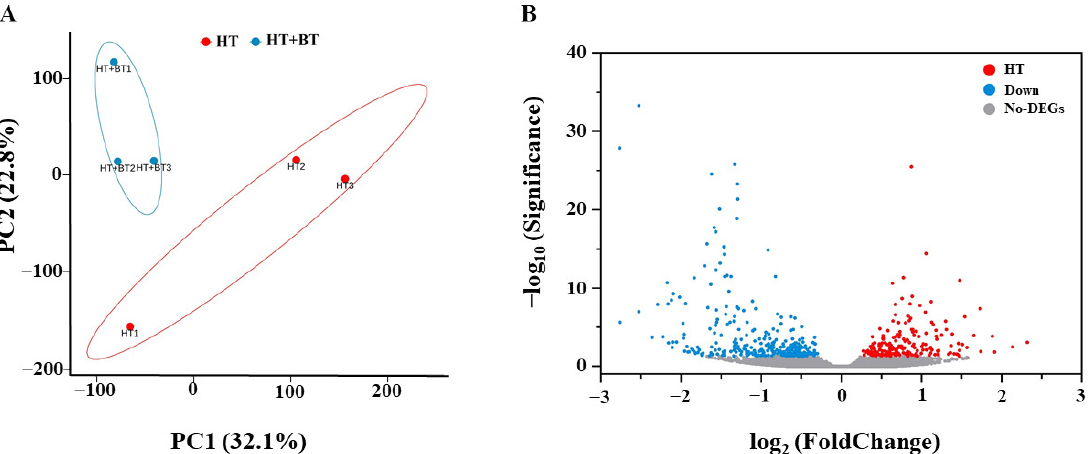
Figure 4. ( A ) HT and HT + BT treatments were the sources of gene expression variation under heat stress. We used principal component analysis to explore the impact on the variation. ( B ) Volcano plots of differentially expressed genes (DEGs) between HT and HT + BT; each point represents a gene. The upregulated genes are represented by red dots, the downregulated genes are represented by blue dots, and the genes with no significant differences are represented by gray dots. Under the corrected Q value, the DEG is considered significantly different.